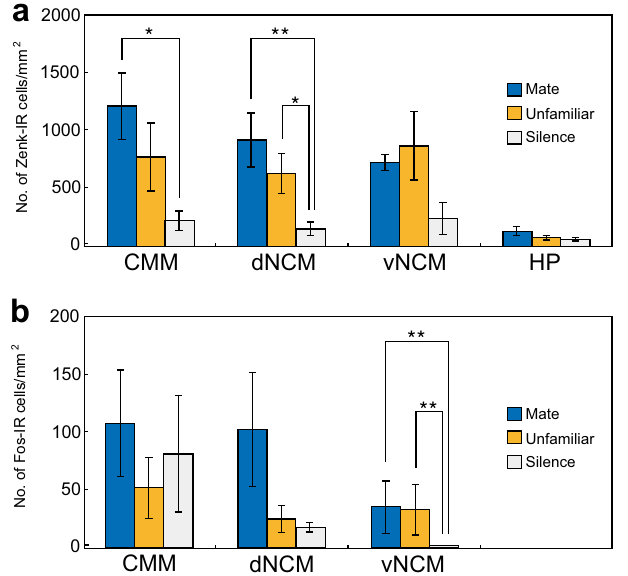
Figure 3. Differential patterns of Zenk and Fos expression in response to CCs in the caudomedial pallium. Mean (± SEM, n = 4) number of IEG-IR cells per square millimetre in the CMM, dNCM, vNCM, and hippocampus (HP) in Zenk expression ( a ) and in the CMM, dNCM, and vNCM in Fos expression ( b ). Statistical significance is indicated by the asterisks (* P < 0.05; ** P <